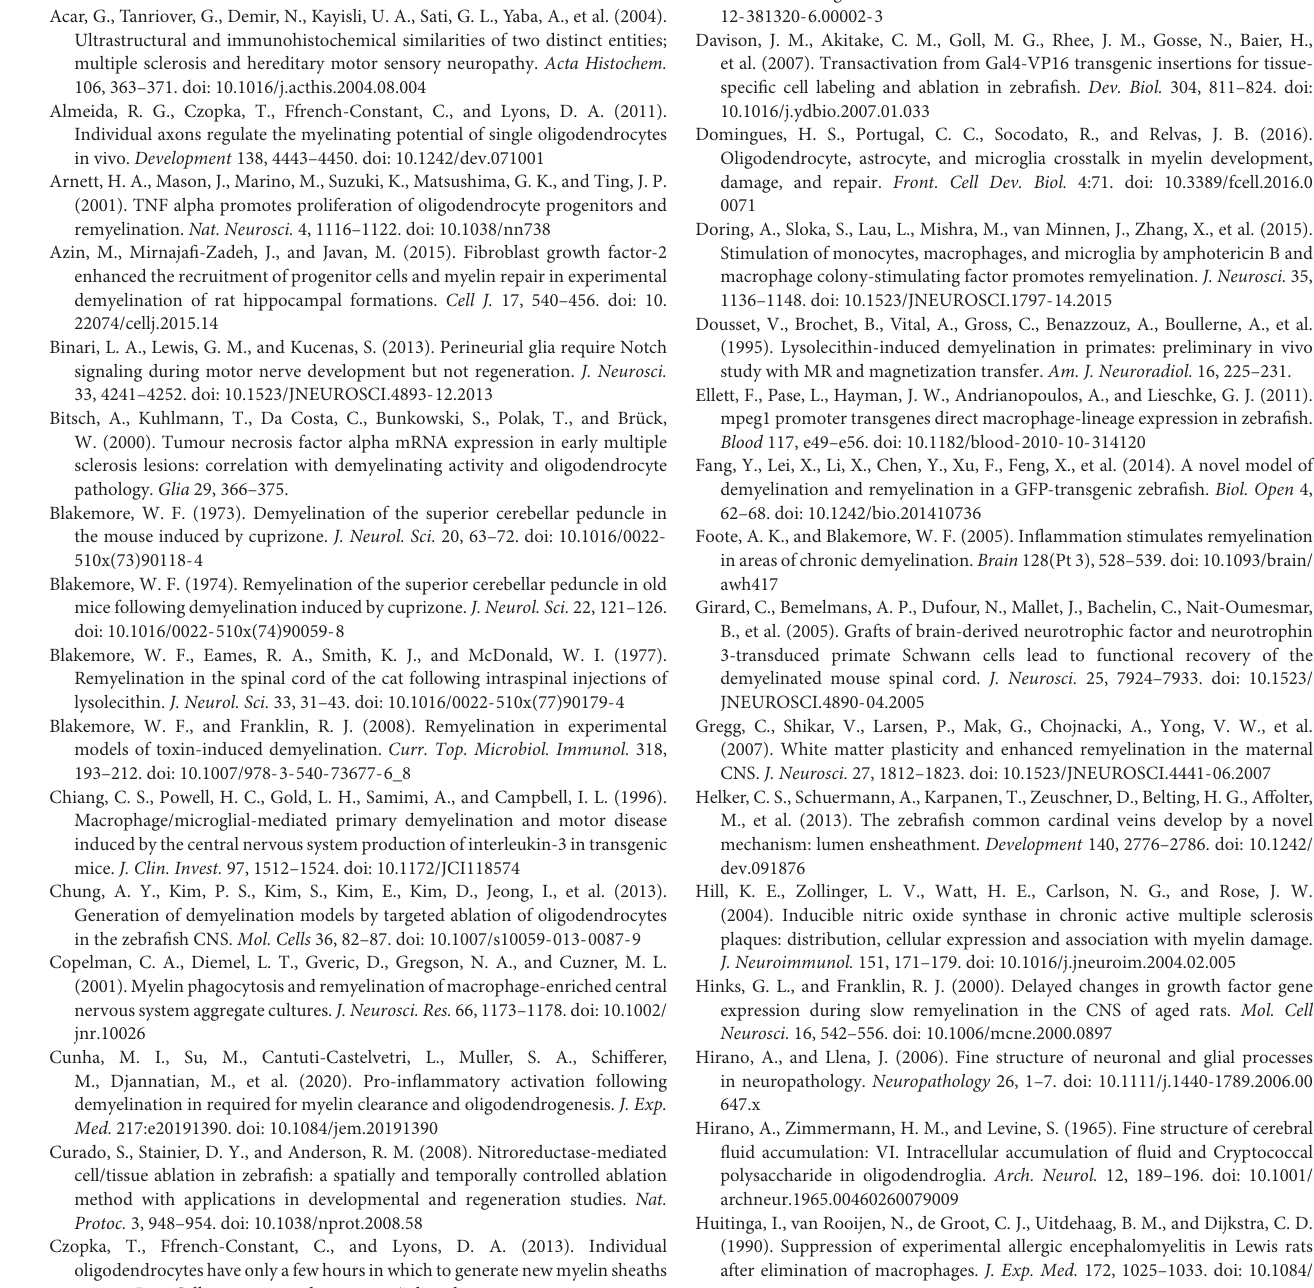
Tg(mbp:egfp-CAAX);Tg(mpeg1:mcherry) larvae imaged from 2 to 10 hpi. Yellow box denotes the site of injection. Pink arrowheads denote the mpeg + cells moving through myelin layers. Images were taken every 6 min, and the movie runs at 10 fps. Supplementary Movie 3 | mpeg + phagocytes proliferate in lysolecithin-injected spinal cords. Lysolecithin was injected into 4 dpf